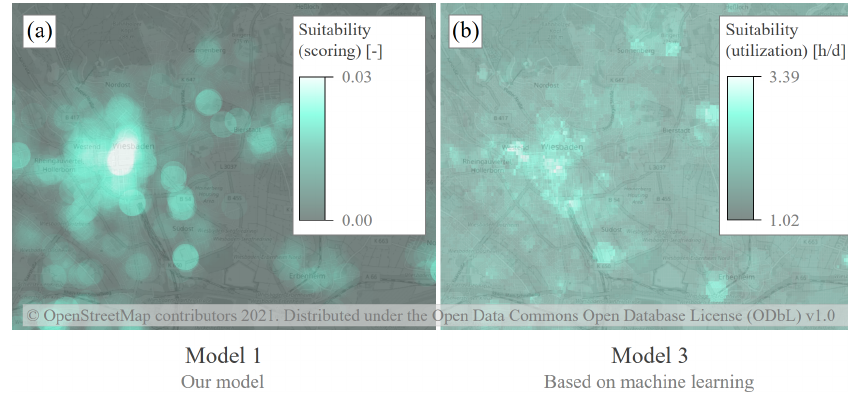
Figure 4. Maps of model 1 and model 3.